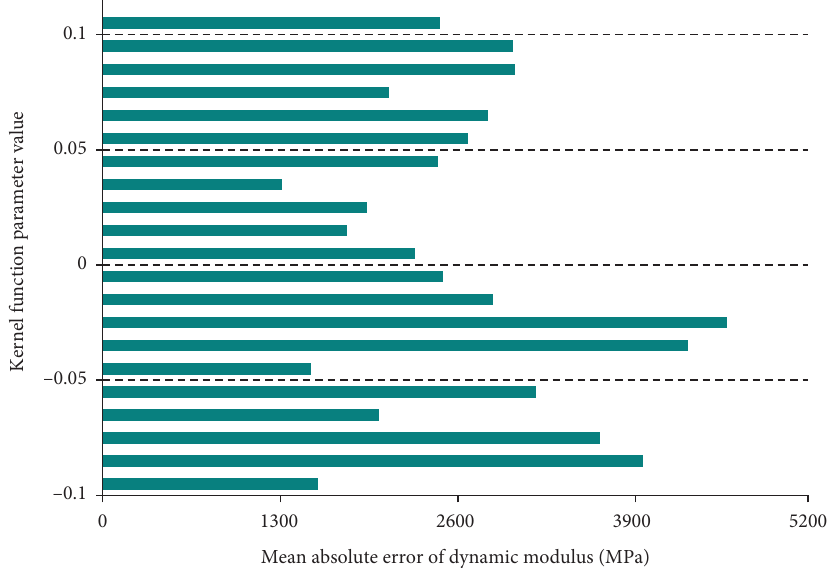
Figure 5: Optimization of penalty parameters and kernel function